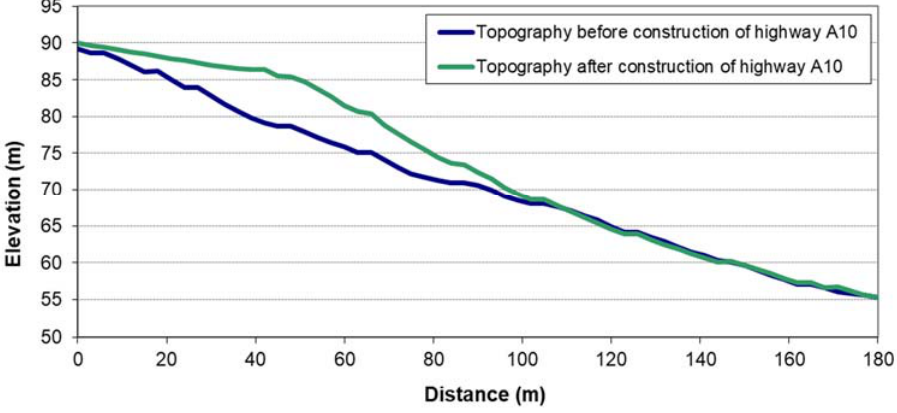
Figure 8. Topography of the slope where the Cachoeira landslide occurred before and after the construction of highway A10.